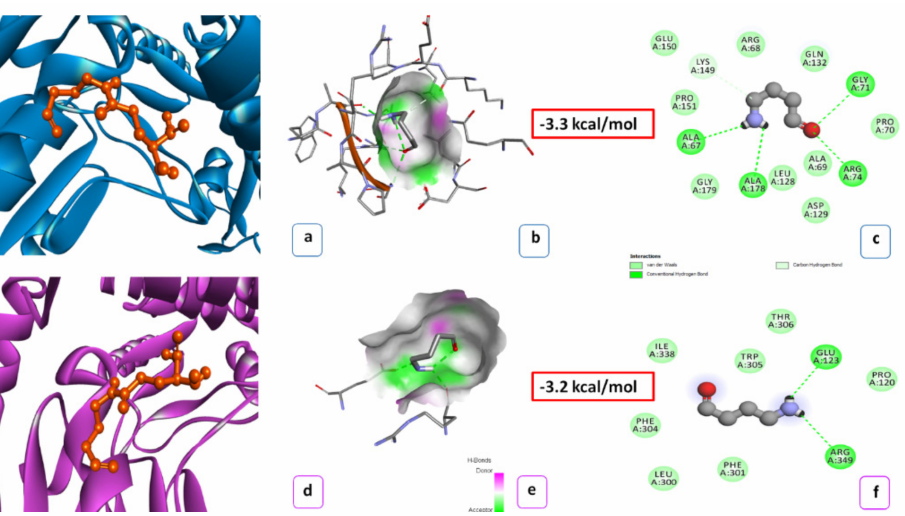
Figure 4. Docking analysis of PaBADH2 with 4-amino butaraldehyde (GAB-ald): ( a ) docked 3D structure of PaBADH2-GAB-ald complex; ( b ) showing H-bond donor (pink) and acceptor (green) surfaces in PaBADH2-GAB-ald complex; ( c ) the 2D view of interacting residues of PaBADH2- GAB- ald complex at ligand binding site that involves H-bond (green circle) and Van der Waals bond (light green circle); ( d ) docked 3D structure of OsBADH2 GAB-ald complex; ( e ) showing H-bond donor (pink) and acceptor (green) surfaces in OsBADH2GAB-ald complex; ( f ) the 2D view of interacting residues of OsBADH2-GAB-ald complex at ligand binding site that involves H-bonds (green circle) and Van der Waals bonds (light green